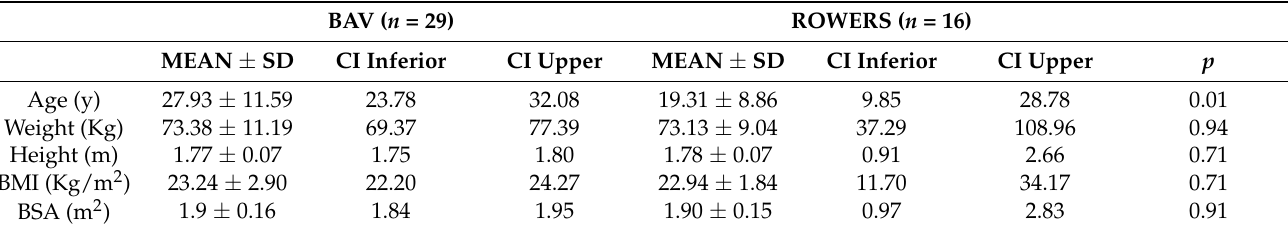
Table 1. Demographic characteristics of the